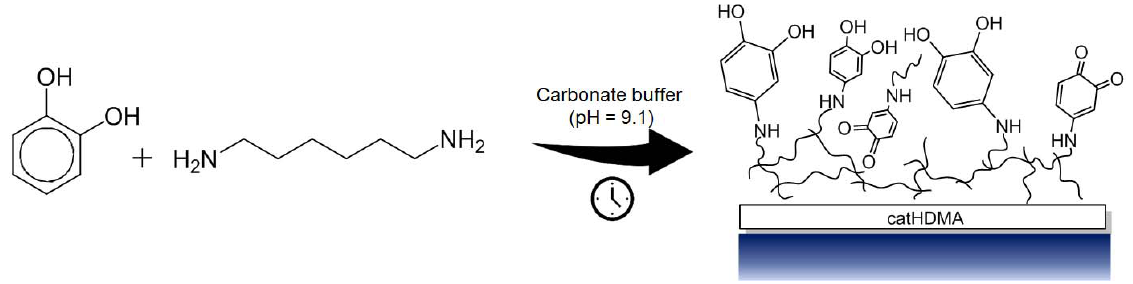
Figure 1. Schematic representation of the copolymerization between pyrocatechol and hexamethylenediamine (catHMDA).